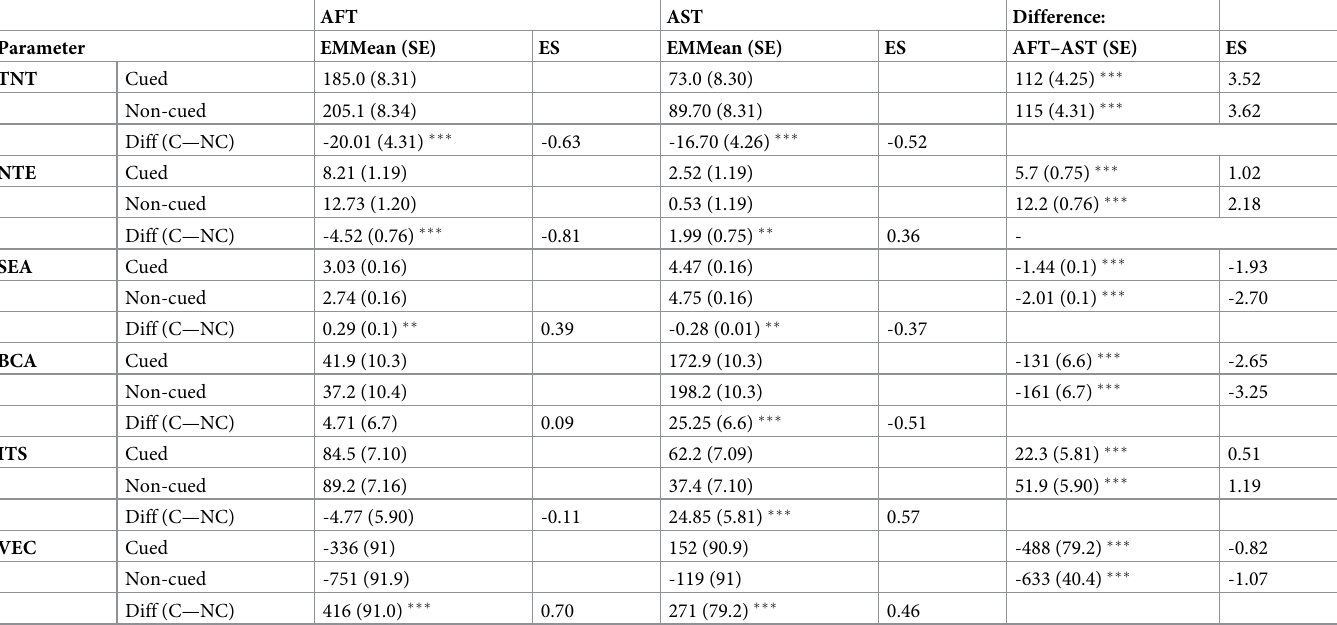
Table 8. Effect of task configuration and cueing on tapping